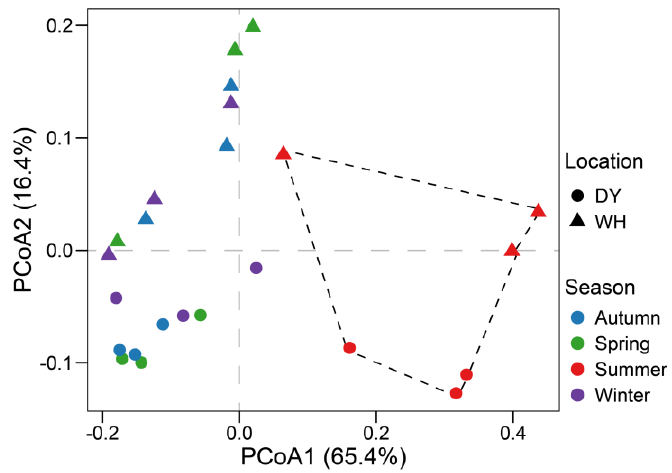
Figure 5. Principal Coordinate Analysis (PCoA) based on the weighted UniFrac distance showing the differences in community structure of archaea collected from different seasons.